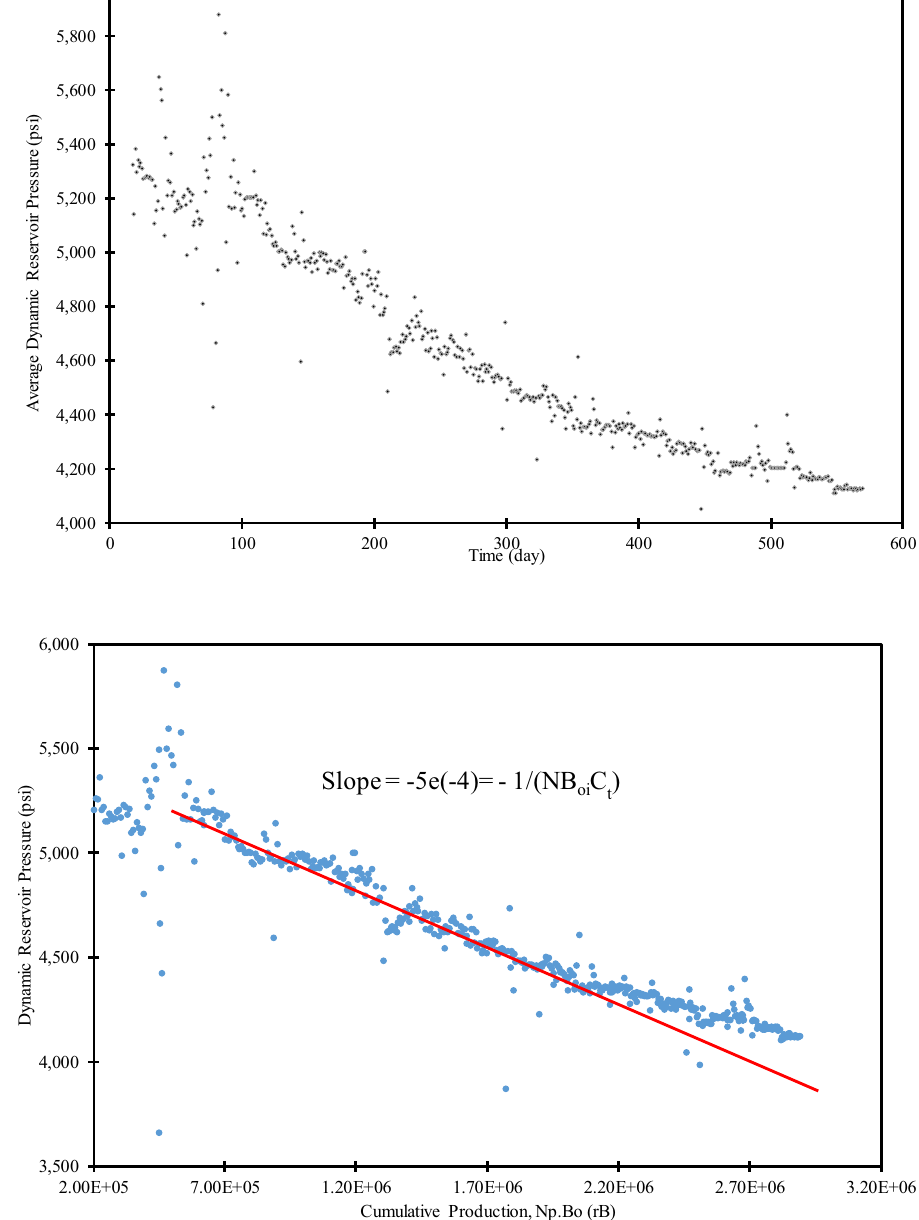
Fig. 5 Average dynamic reser-